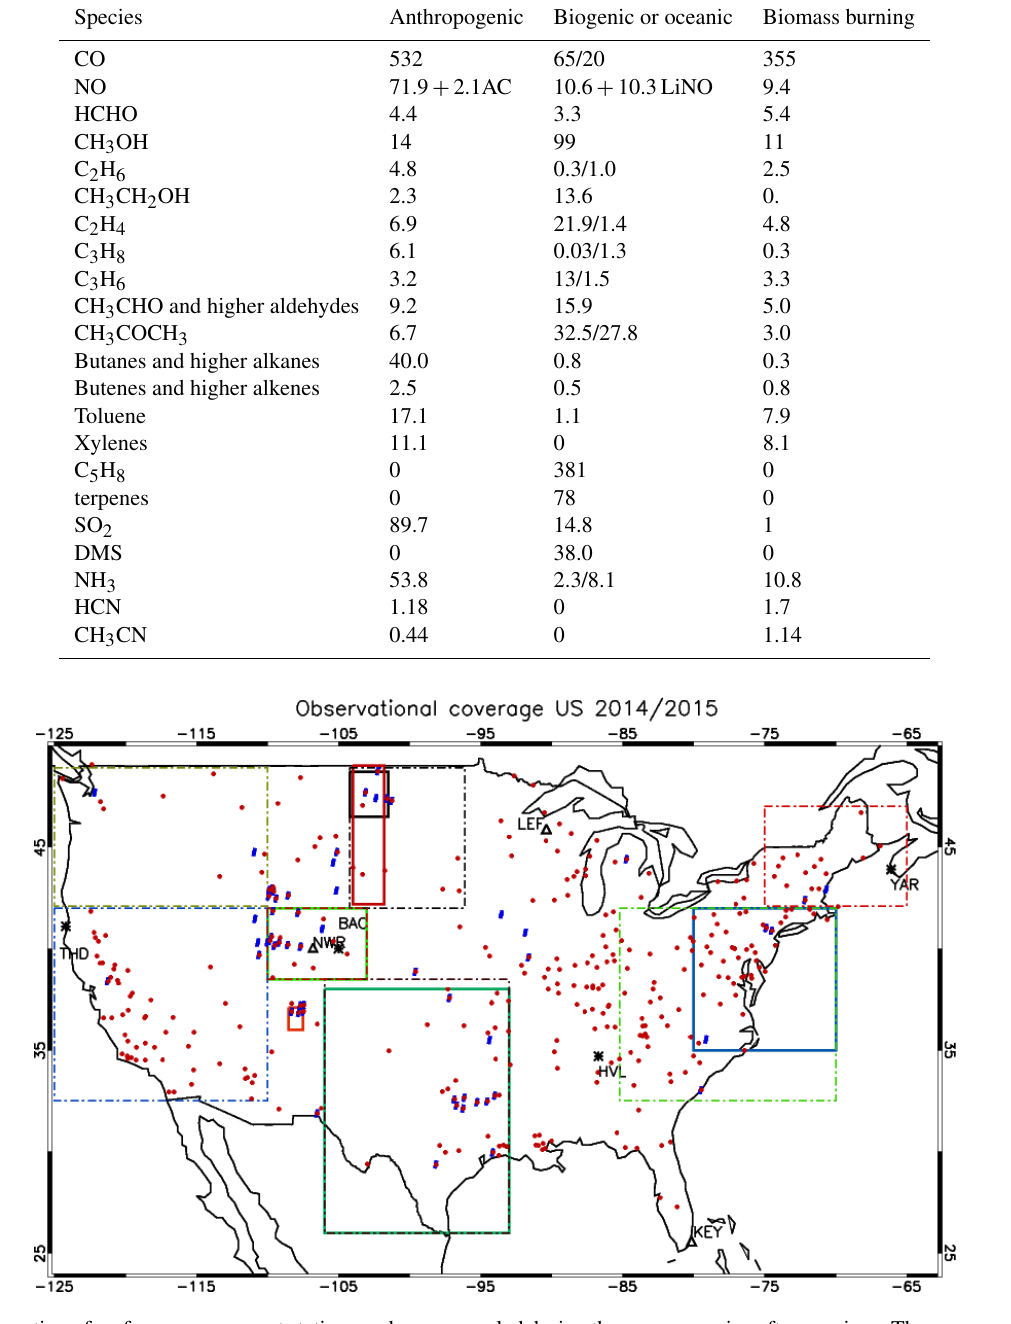
Figure 1. The location of surface measurement stations and areas sampled during the numerous aircraft campaigns. The ozonesonde locations are shown as ∗ , and the GFDL surface sites are shown as (cid:49) . Key to airshed definitions: North Dakota (May 2014, full black), New Mexico (June 2014, full red), Colorado (July–August 2014 and March–April 2015, light green), Eastern Coast (February–March 2015, full dark blue) and south central US (April 2015, full dark green). The areas outlined by the dashed and dotted borders are associated with the regions for which the AirNow observations are analyzed, with the reader being referred to Table 6. The individual stations for the AirNow network are shown as red dots (O 3 ), and blue dots (NO 2 ) are used for rural stations